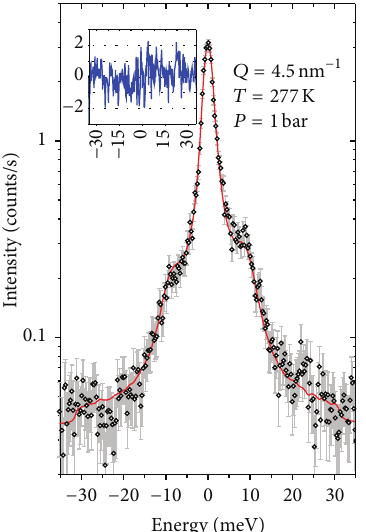
Figure 13: A typical IXS spectrum measured in water [13] compared with corresponding best fit line-shape obtained with the memory function in (10) as discussed in the text. The residual of the fit is reported in the